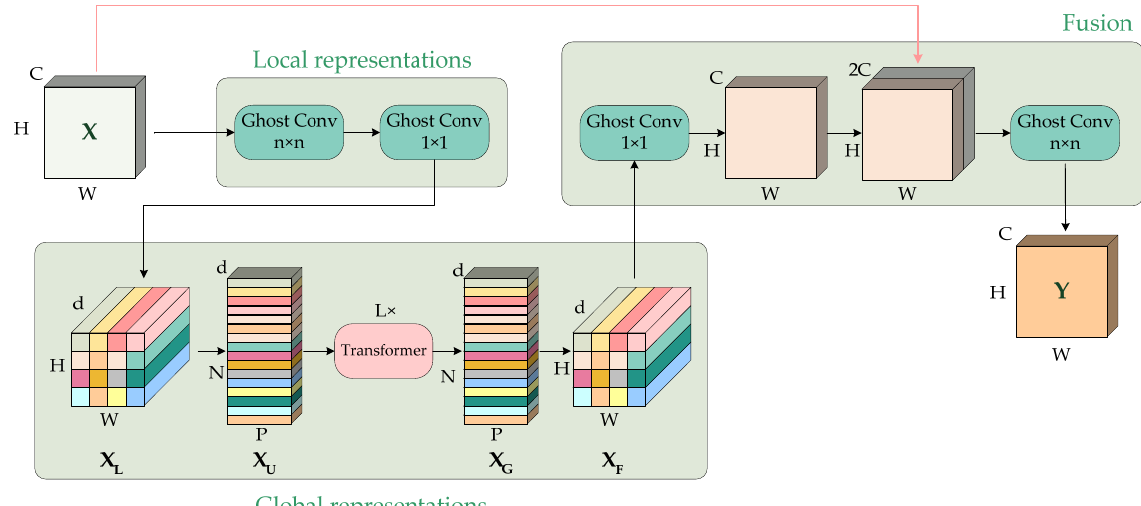
Figure 8. Ghost–MobileViT Block.